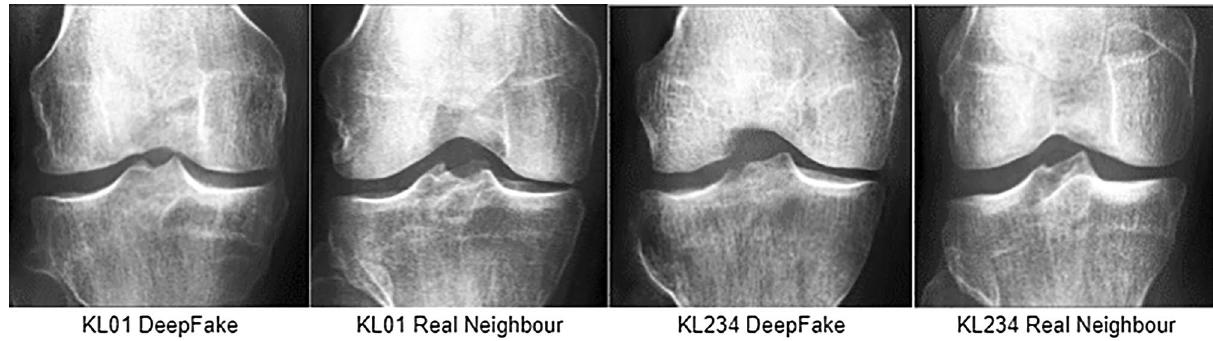
Figure 8. Topmost closest K-nearest neighbors of real images to DeepFake images. The nearest neighbors were computed in InceptionV3 vector space. The first two images are the top closest (shortest distance) KL01 pair, while the second pair are the top closest KL234 pair. These and the remaining sets were shown to the orthopedic surgeon for overfitting validation.